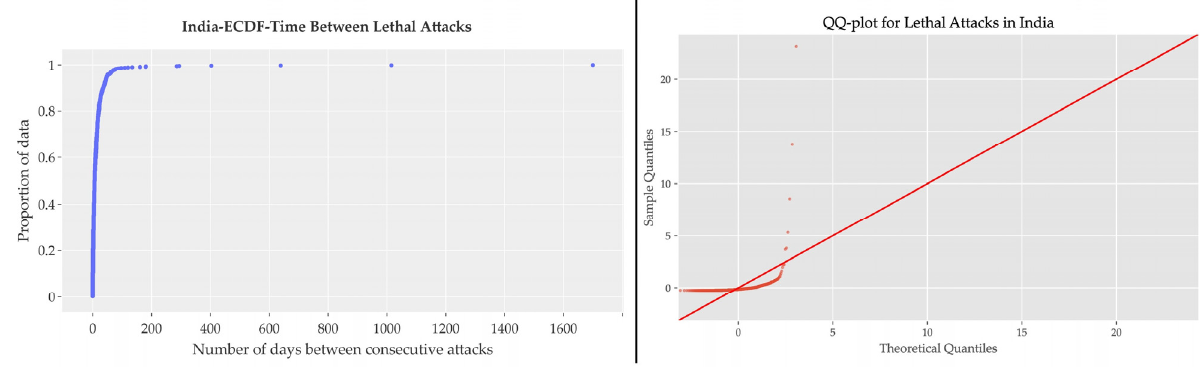
Figure 12. Ripley’s G(d) function for Pakistan.